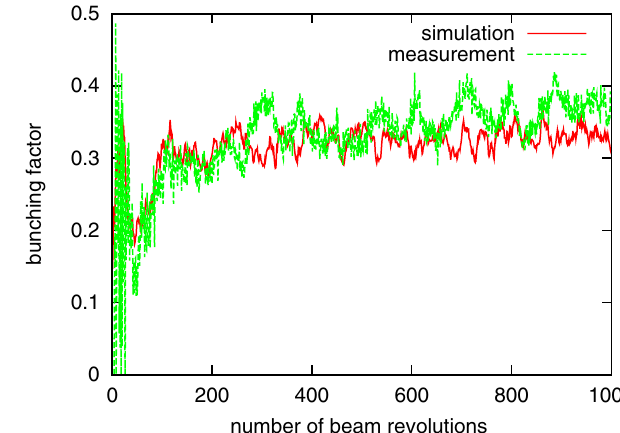
FIG. 8. (Color) Comparison between the simulation and mea- surement, with 80% second harmonic, momentum offset of (cid:1) 0 : 2% , and phase sweep of 60 degrees.